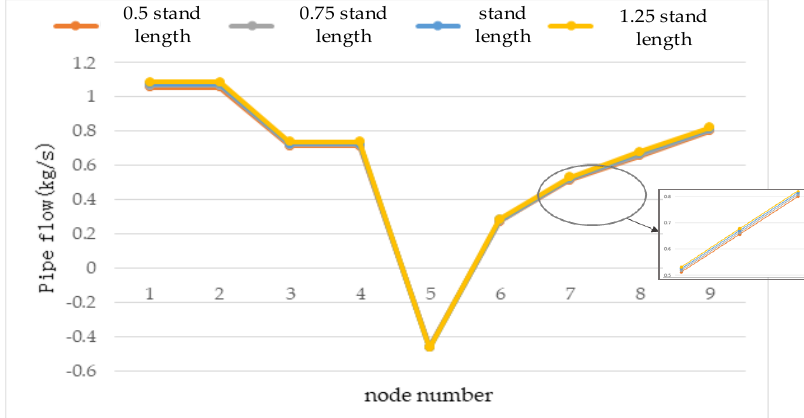
Figure 11. Pipeline flux under different pipeline lengths.